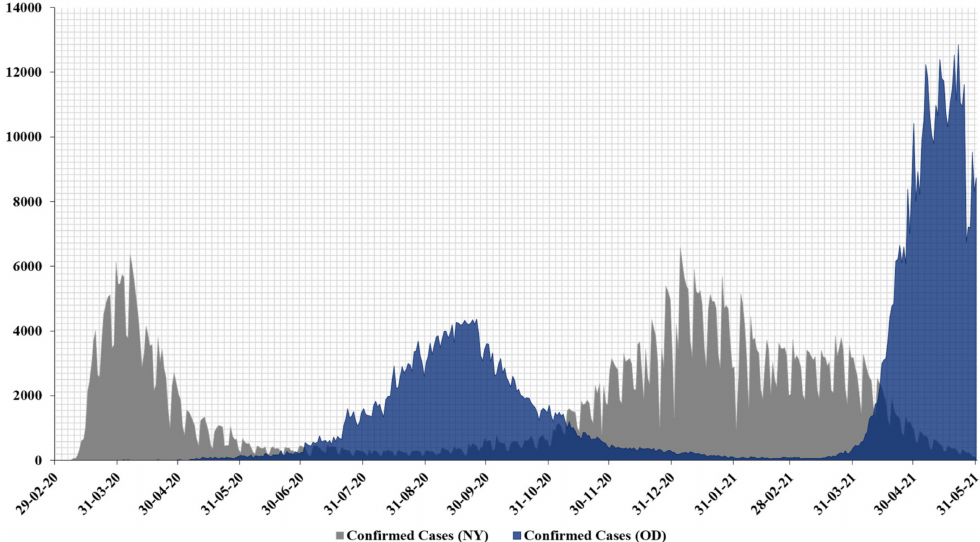
Figure 3. A yearlong epidemiological curve from 29 February 2020 to 31 May 2021, showing the first wave and second wave of COVID-19. The figure depicts the COVID-19 outbreak trend in the state of OD (blue) and NY (gray) during the aforementioned timeline. Abbreviations: OD, State of Odisha, India. NY, State of New York,